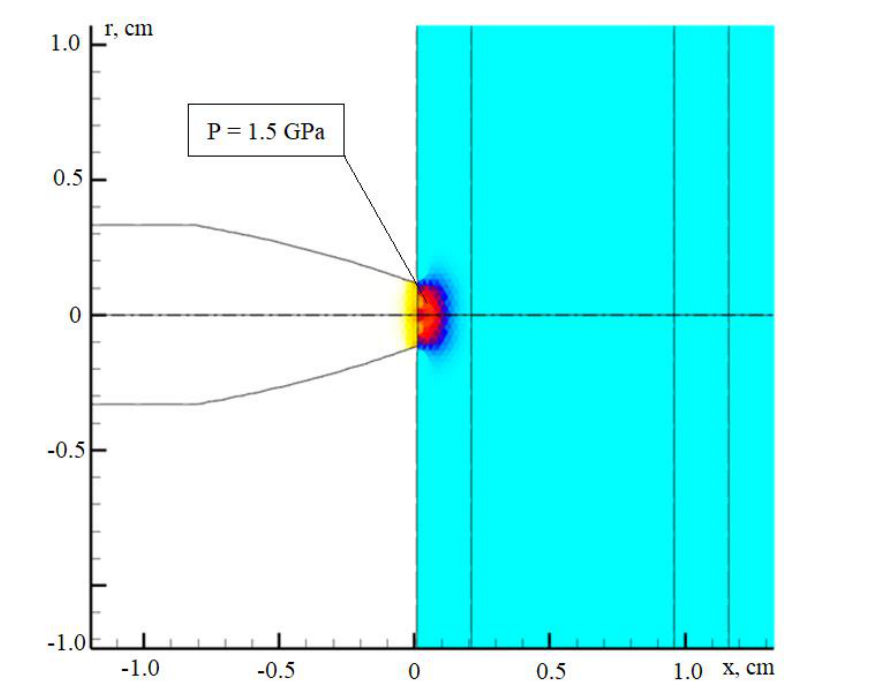
Fig. 5. The formation of a compression wave when the core contacts the protective element.